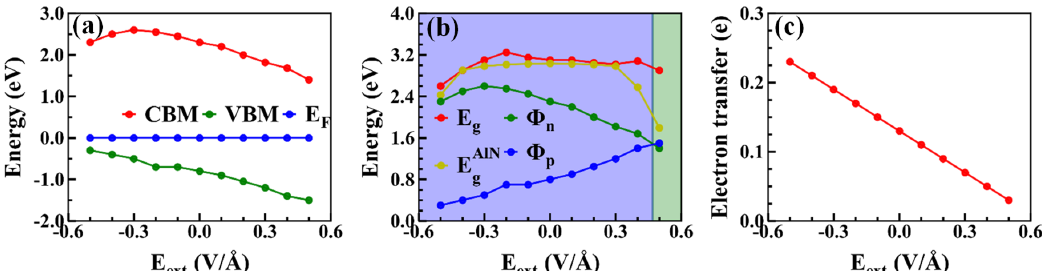
Figure 5. ( a ) The varying trends of CBM, VBM, and Fermi level E F with respect to the external electric field. ( b ) The Schottky barriers Φ n , Φ p , and bandgap E g ( E AlN g ) as a function of the external electric field. ( c ) The electron transfer amount from AlN to graphene as a function of the external field.